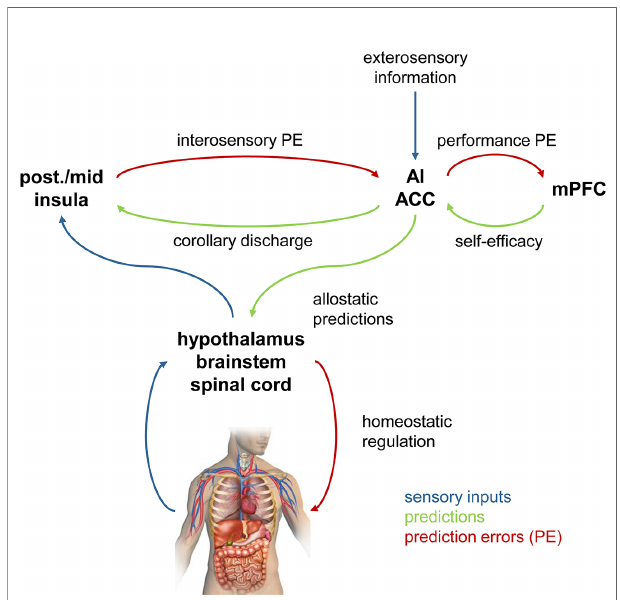
FIGURE 4 | A hypothetical anatomical circuit for homeostatic and allostatic regulation (87). The lower part represents a re fl ex arc in which homeostatic beliefs about bodily states (represented in hypothalamus, brainstem, spinal cord) are defended (protected) against deviations, by eliciting actions that depend on precision-weighted prediction errors. The upper part represents a cortical hierarchy for perceptual inference that is capable of modulating the homeostatic beliefs via descending connections and can implement anticipatory (allostatic) control. A top metacognitive layer (tentatively assigned to medial prefrontal cortex) holds beliefs about performance levels (i.e., levels of prediction errors at the top of the hierarchy). Colors have the same meaning throughout this fi gure, as indicated by the legend. It is important to keep in mind that in Bayesian treatments of inference-control loops, the direction in which predictions and prediction errors are signaled reverses when switching from the afferent branch (perception) to the efferent branch (action). For example, in the afferent branch, prediction errors are signaled upwards in the hierarchy, whereas in the efferent branch, they are used by descending projections to inform actions. post., posterior; ACC, anterior cingulate cortex; mPFC, medial prefrontal cortex. Reproduced from Figure 3 in Manjaly et al. (87), with permission from BMJ Publishing Group